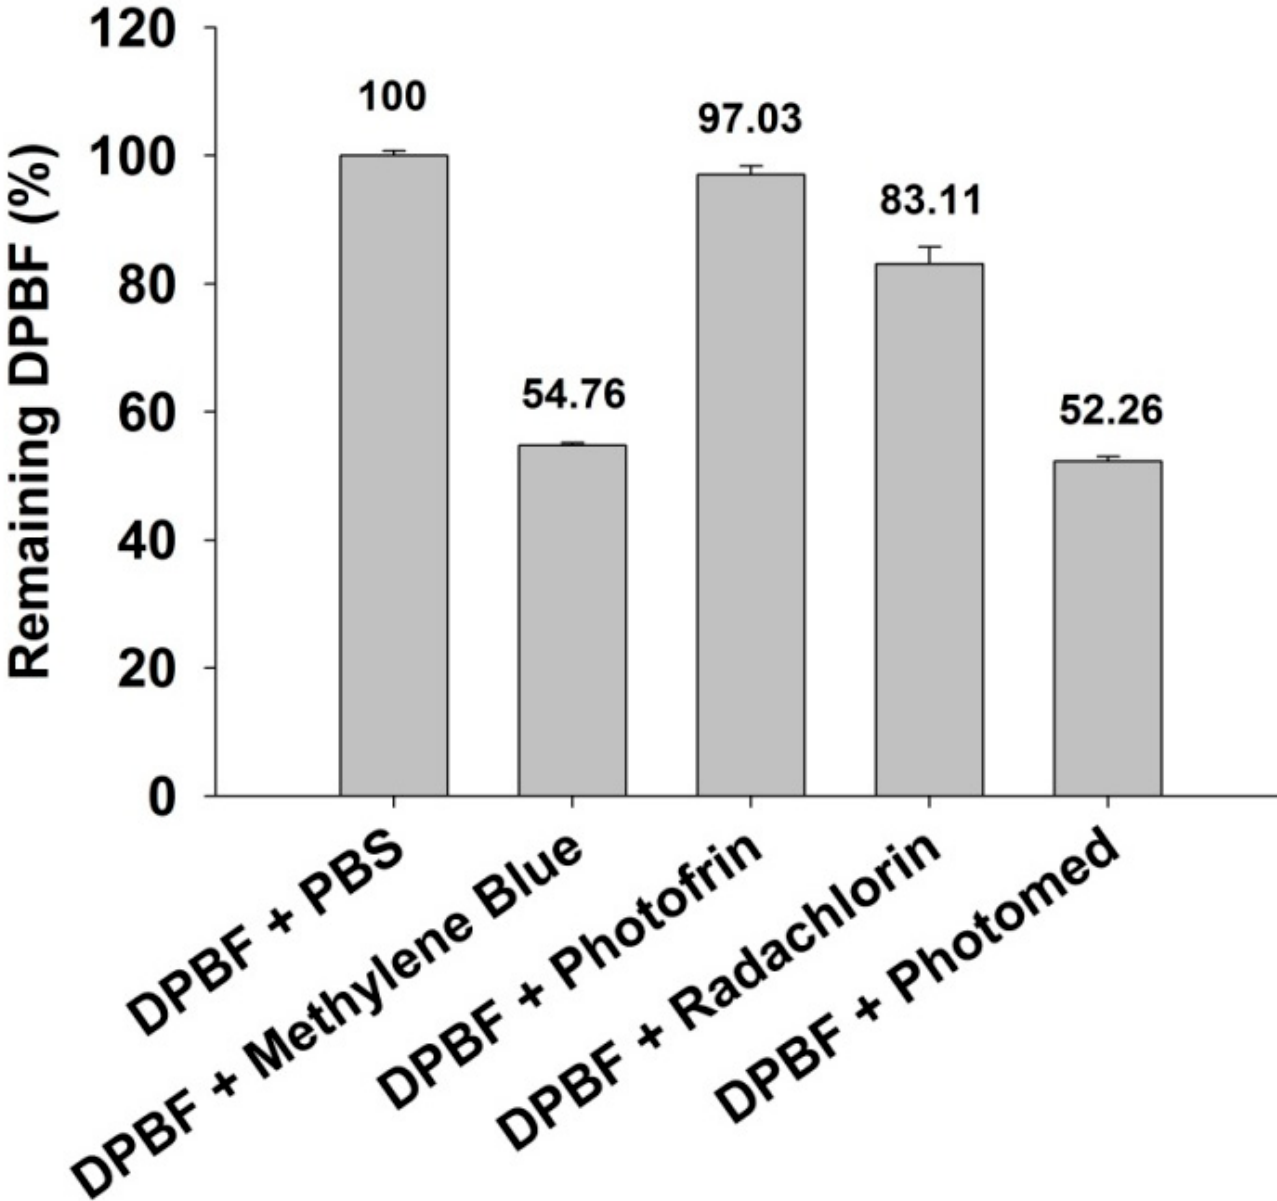
Figure 2. Singlet oxygen photogeneration assay. PBS, 1 µ M of methylene blue or photosensitizers (Photofrin, Radachlorin and Photomed) were added to 50 µ M of 1,3-diphenylisobenzofuran (DPBF) solution and irradiated (5 mW/cm 2 , 400 s) with the proper wavelength (630 nm for Photofrin and 662 nm for Radachlorin and Photomed) of PDT lasers. Remaining DPBF was measured at 418 nm absorbance. Data are presented as means ± SD ( n = 3).